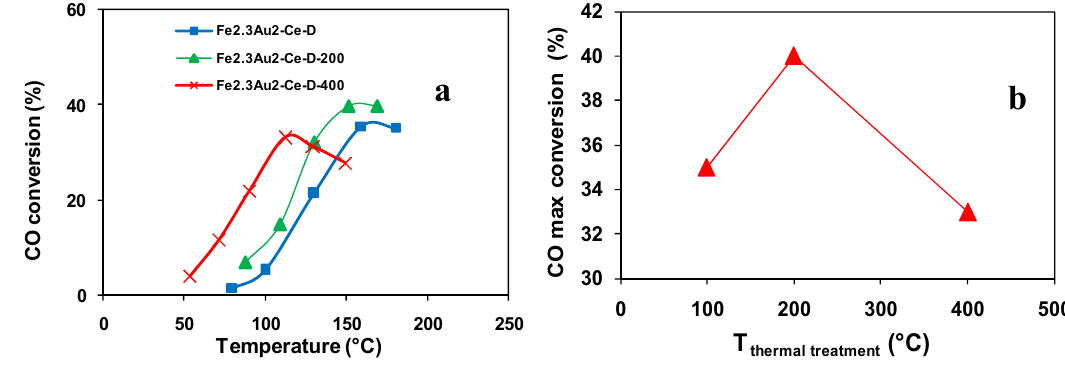
Figure 11. CO conversion ( a ) and CO maximum conversion ( b ) on Fe samples depending on thermal treatment temperature. Symbols: Fe Fe Au -Ce-D-200 ( ▲ ), Fe 2.3 2